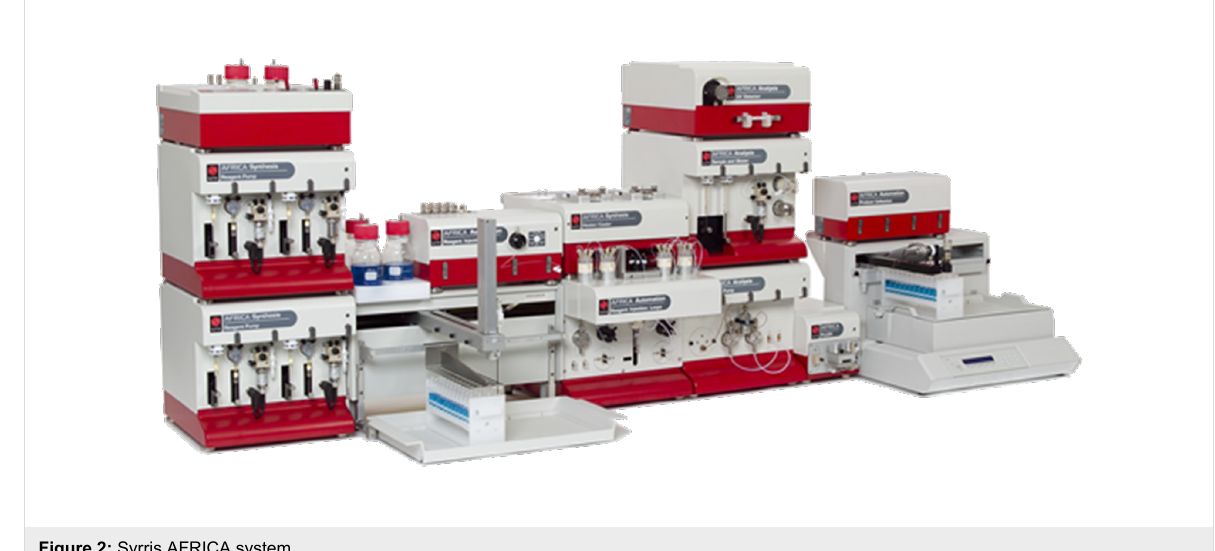
Figure 2: Syrris AFRICA